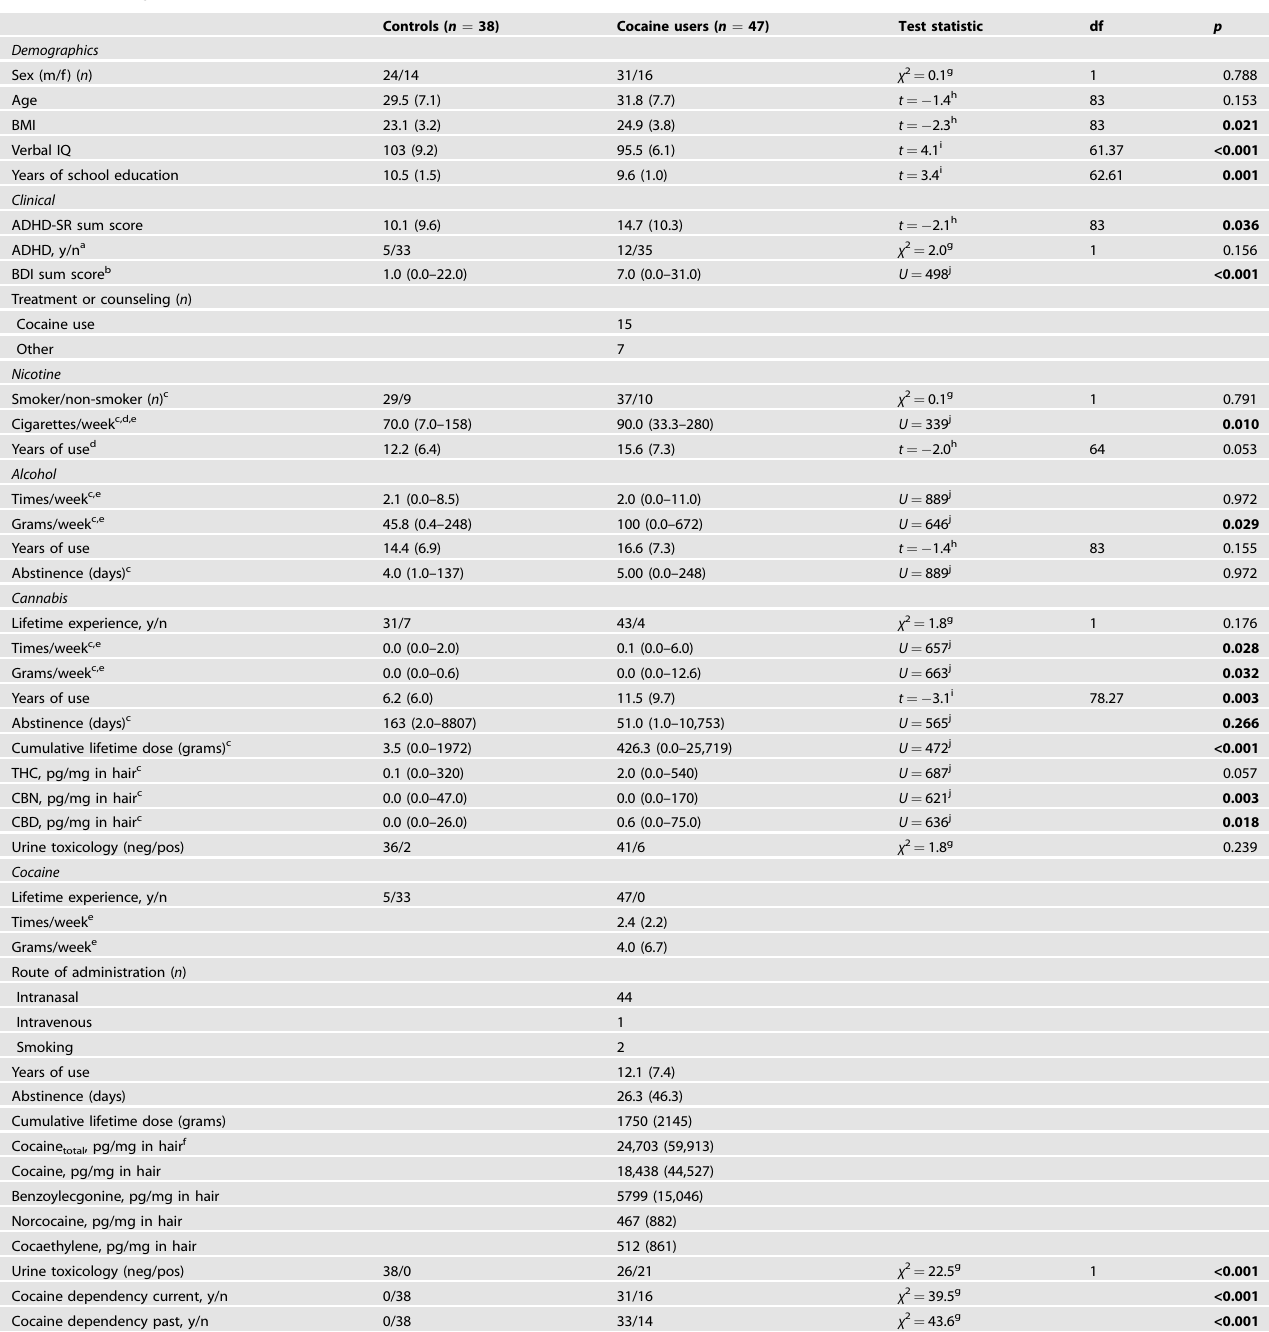
Table 1. Demographic, clinical, and substance use-related